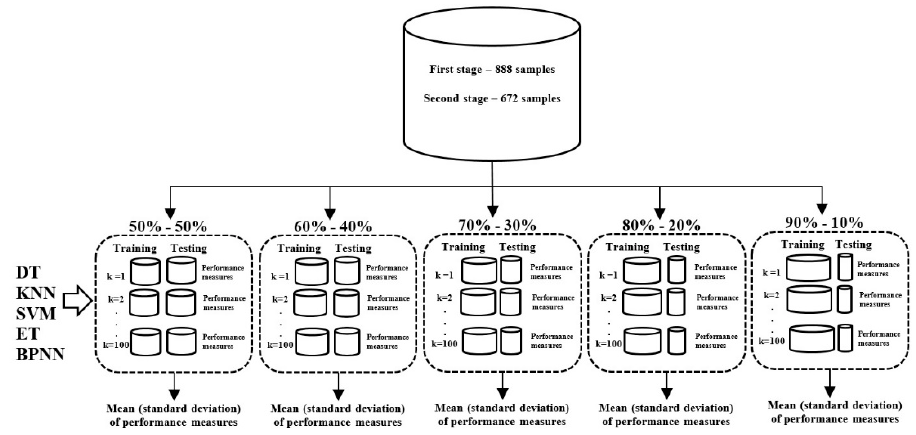
Figure 13. Data preparation for repeated random trials.